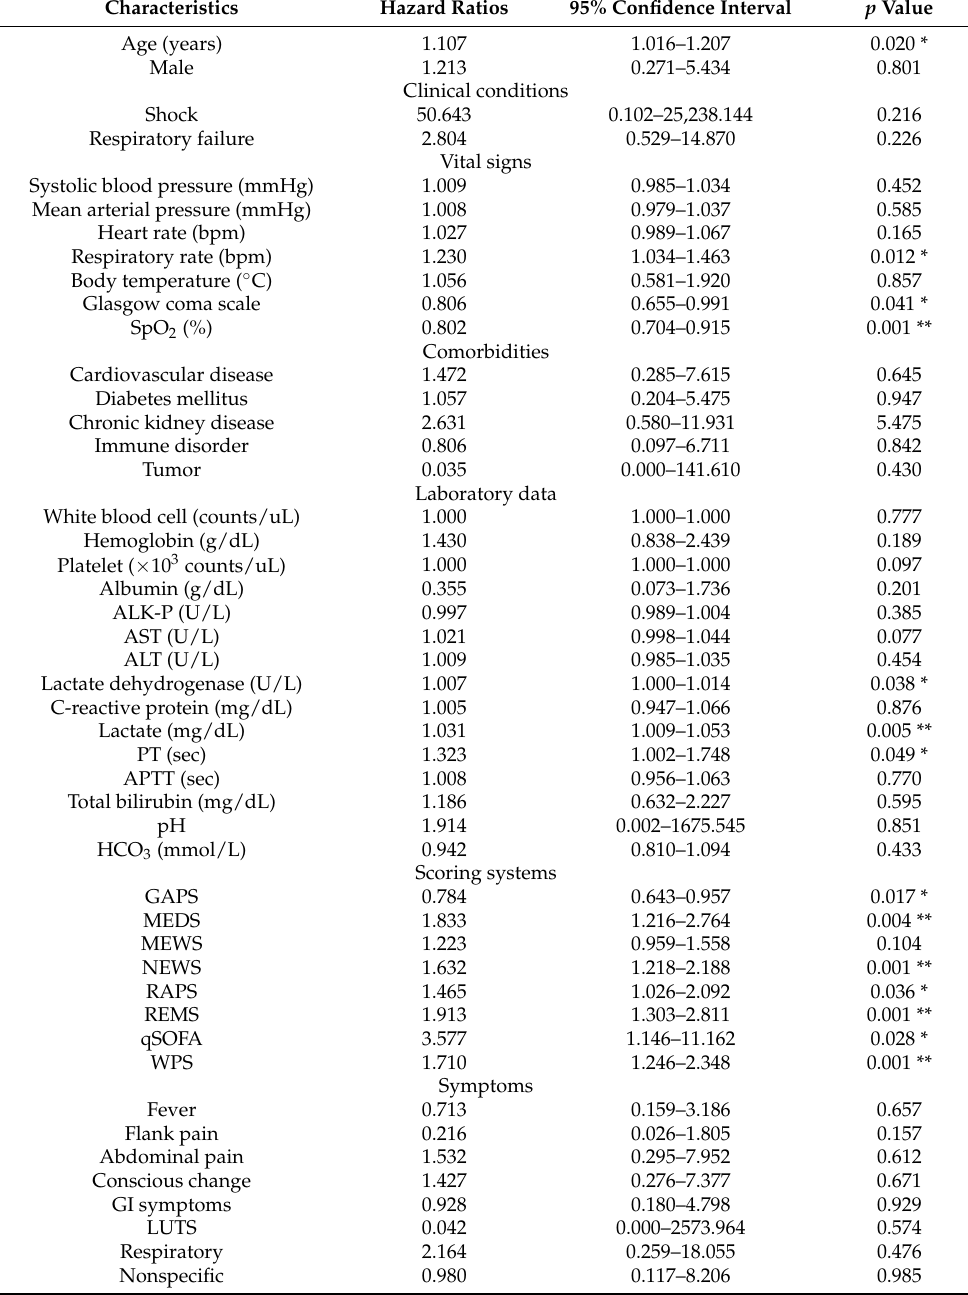
multivariate Cox regression analyses for the clinical outcomes of EPN were summarized in Table 7. The scores of MEDS ( p = 0.004), NEWS ( p = 0.001), qSOFA ( p = 0.043), and WPS ( p = 0.001) had significantly higher HRs in non-survivors than in survivors, unlike GAPS ( p = 0.0017). Table 6. Hazard ratios and 95% confidence interval of univariate